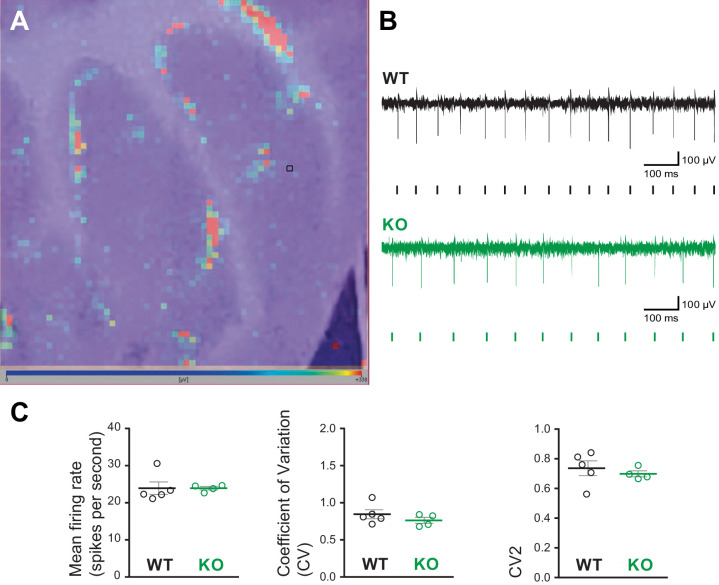
High-density microelectrode array (MEA) analysis of Purkinje cell spiking in acute cerebellar slices from Susd4 knockout (KO) compared to Susd4 wild type (WT).(A) Image of a cerebellar acute slice from a WT mouse overlapped with the image of the color map of the MEA recording. Each pixel represents one channel, where the active units are in red. The black square highlights one of the channels. (B) Representative traces of electrical activity recorded in one channel from Susd4 WT and KO mice. Each tick points out one action potential that has been detected and sorted by the Brainwave software. (C) Histograms of the mean firing rate, coefficient of variation (CV) of interspike intervals, and CV2. Mean ± s.e.m. (WT n = 5 and KO n = 4 mice; Mann-Whitney test; mean firing rate: p=0.2857; CV: p=0.4127; CV2: p=0.5373).